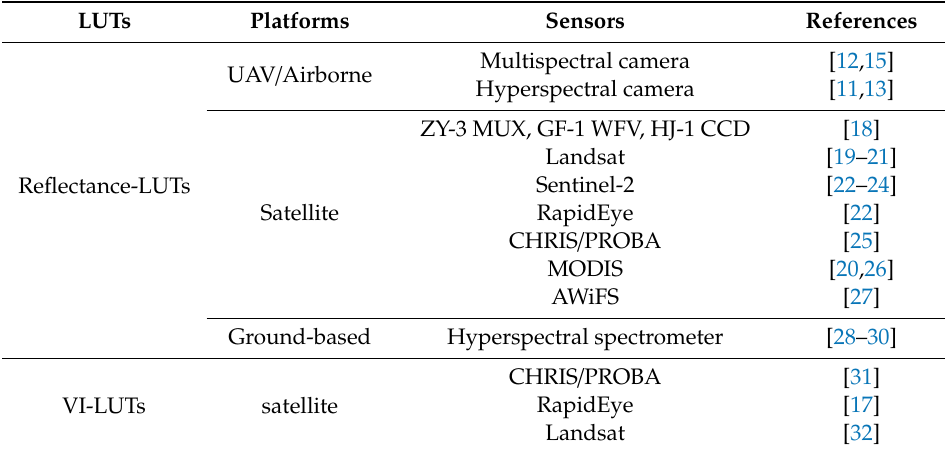
Table 1. Summary of LAI retrieval based on LUTs generated from the PROSAIL model.